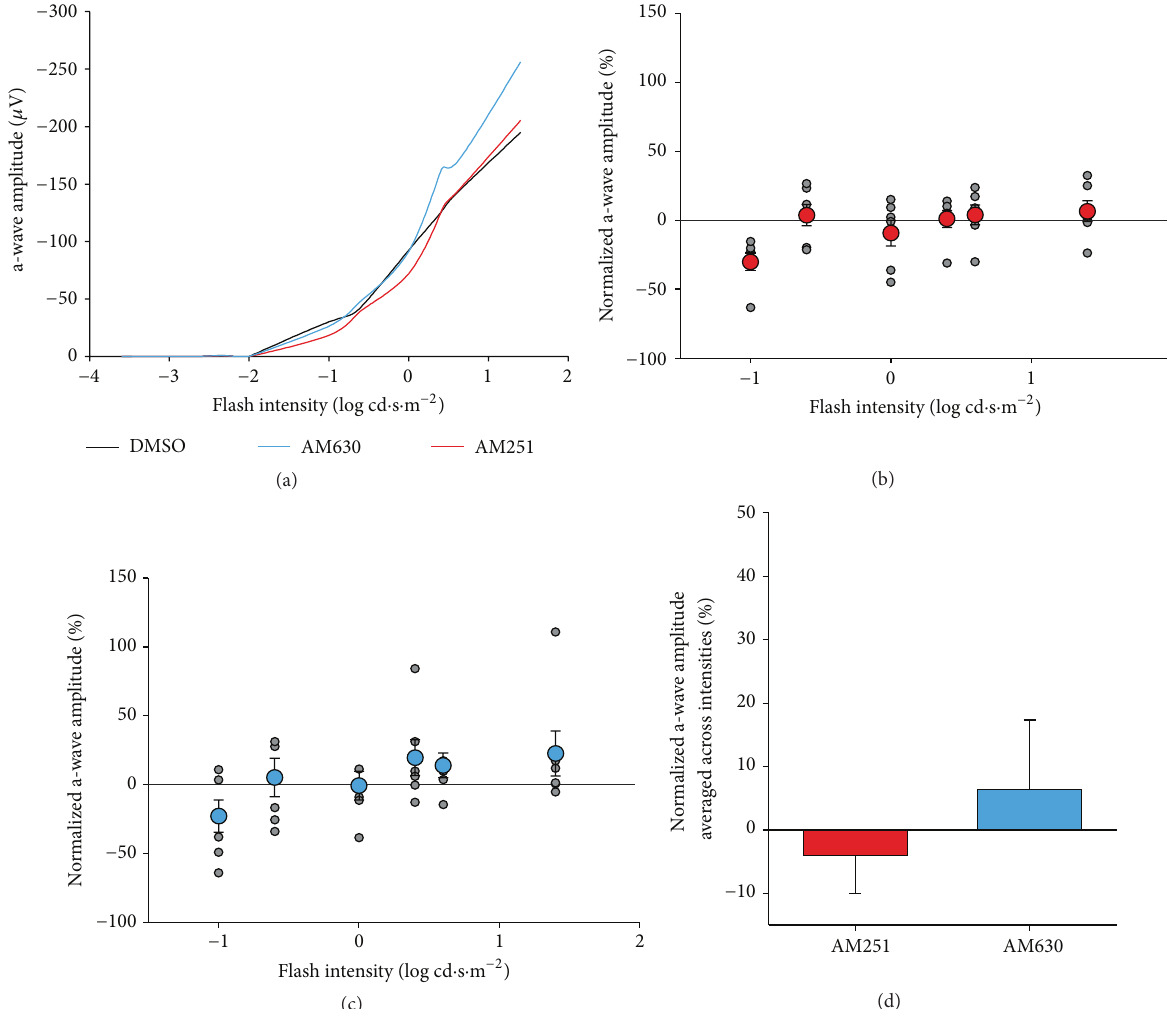
Figure 7: Scotopic a-wave amplitudes. (a) Amplitudes of scotopic ERG a-waves plotted as a function of flash intensities. (b) Scatter plot for normalized a-wave amplitude as a function of flash intensity in AM251-injected monkeys. Grey points indicate raw values; red data points with error bars indicate the mean and standard error of the mean. (c) Scatter plot for normalized a-wave amplitude as a function of flash intensity in AM630-injected monkeys. Grey points indicate raw values; blue data points with error bars indicate the mean and standard error of the mean. (d) Main effect of average amplitudes across intensities in AM251 (red) or AM630 (blue) groups. Error bars represent standard error or the